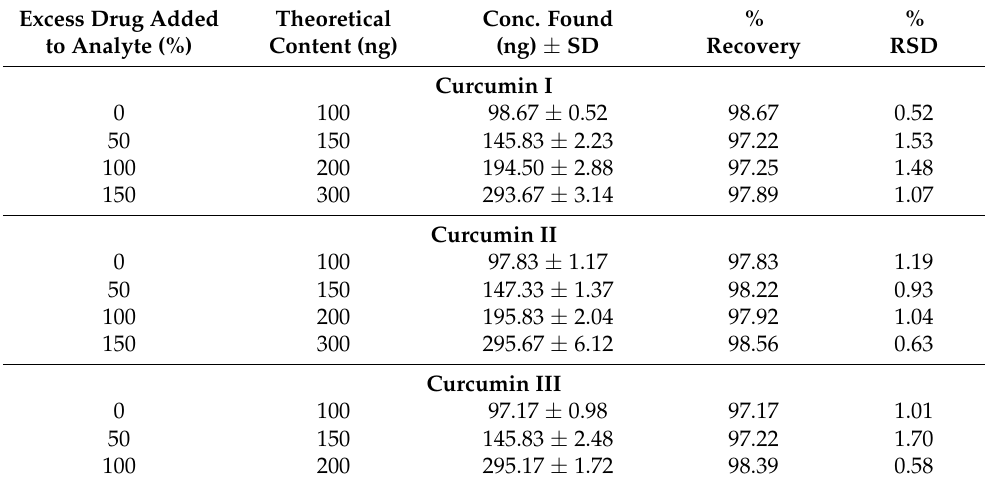
Table 2. Accuracy of the proposed method of curcumins I–III ( n = 6).